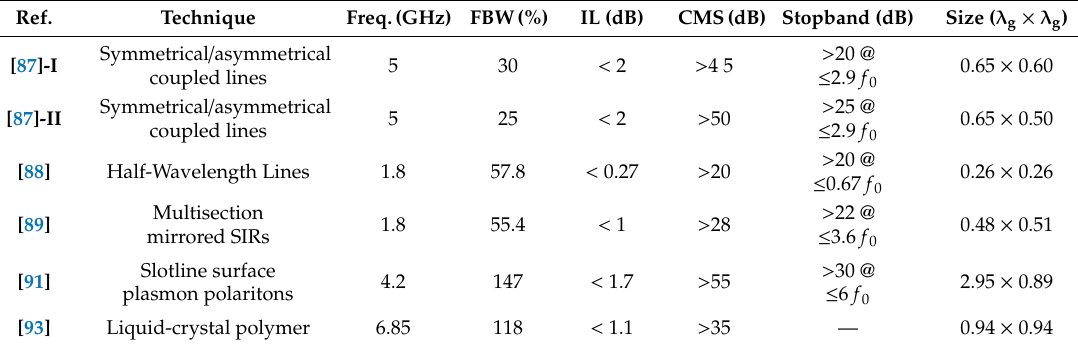
Table 4. Performance comparisons for some recent wide-band and ultra-wideband di ff erential microstrip